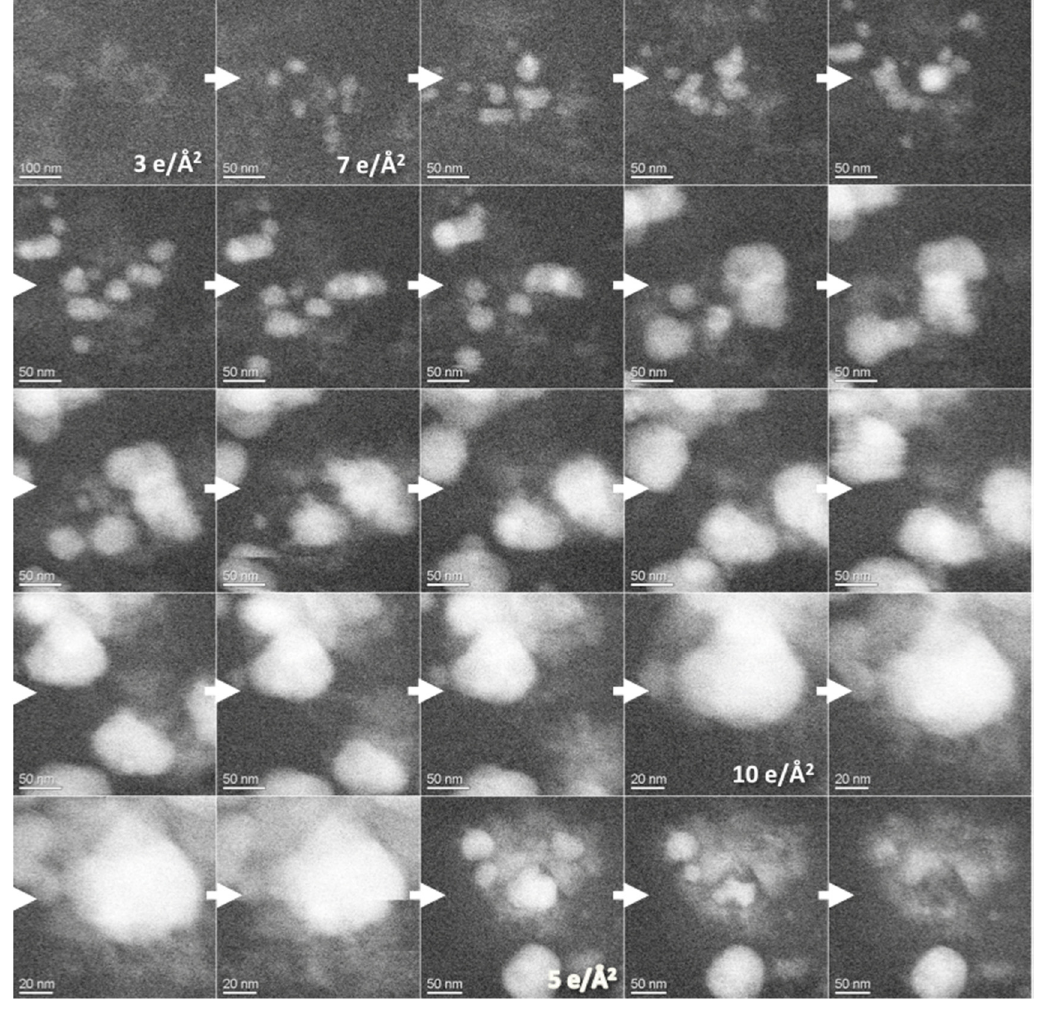
Figure 2. Sequence of LCSTEM stills from a video recording electron beam induced calcium carbonate formation from 10 mM supersaturated solution of Ca 2+ and CO 32 − ions and subsequent dissolution of most of the nanoparticles upon reduction of electron dose. Electron dose values were between 3e/Å and 10 e/Å and are indicated in the stills when changed. The whole frame frequency was recorded within a time interval of approx. 120 s, hence each frame was recorded at increment time steps of approx. 5 s with a recording time of 0.5 s.